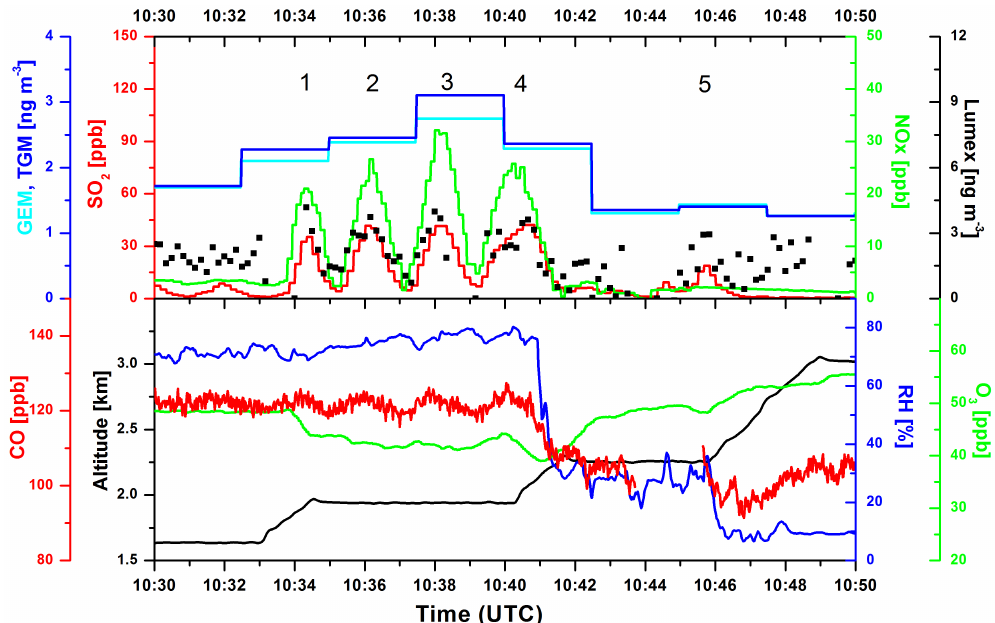
Figure 4. ETMEP-2 lignite-fired power plant plume measurements on 21 August 2013 south of Leipzig, Germany. The gaps in the Lumex signal (10s resolution) are due to internal zero air checks for the correction of the baseline drift of the instruments. GEM was measured using a Tekran instrument run with a quartz wool trap at the inlet of the instrument, which is presumed to remove GOM. TGM was measured by another Tekran instrument with no quartz wool trap at the inlet. All parameters were synchronized using individual instrument delay and response times. All Hg concentrations are given at standard temperature and pressure (STP; T = 273.15 K, p = 1013.25hPa).